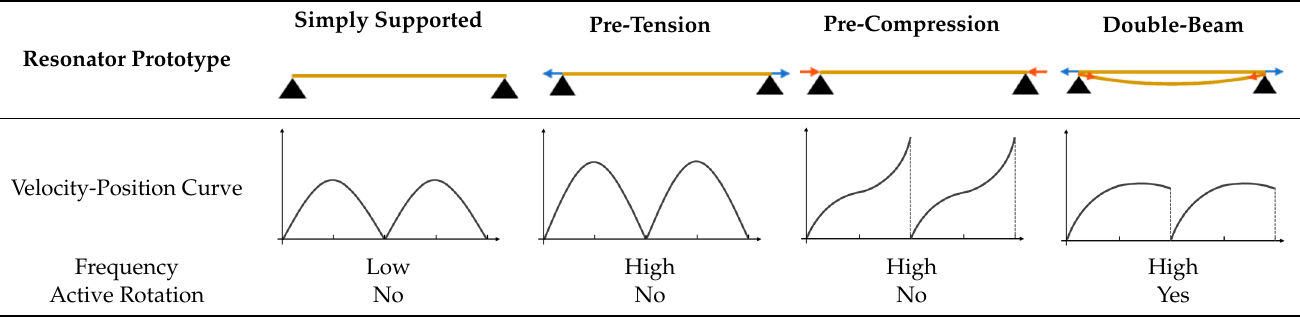
Table 2. The Properties of the Different Resonator.